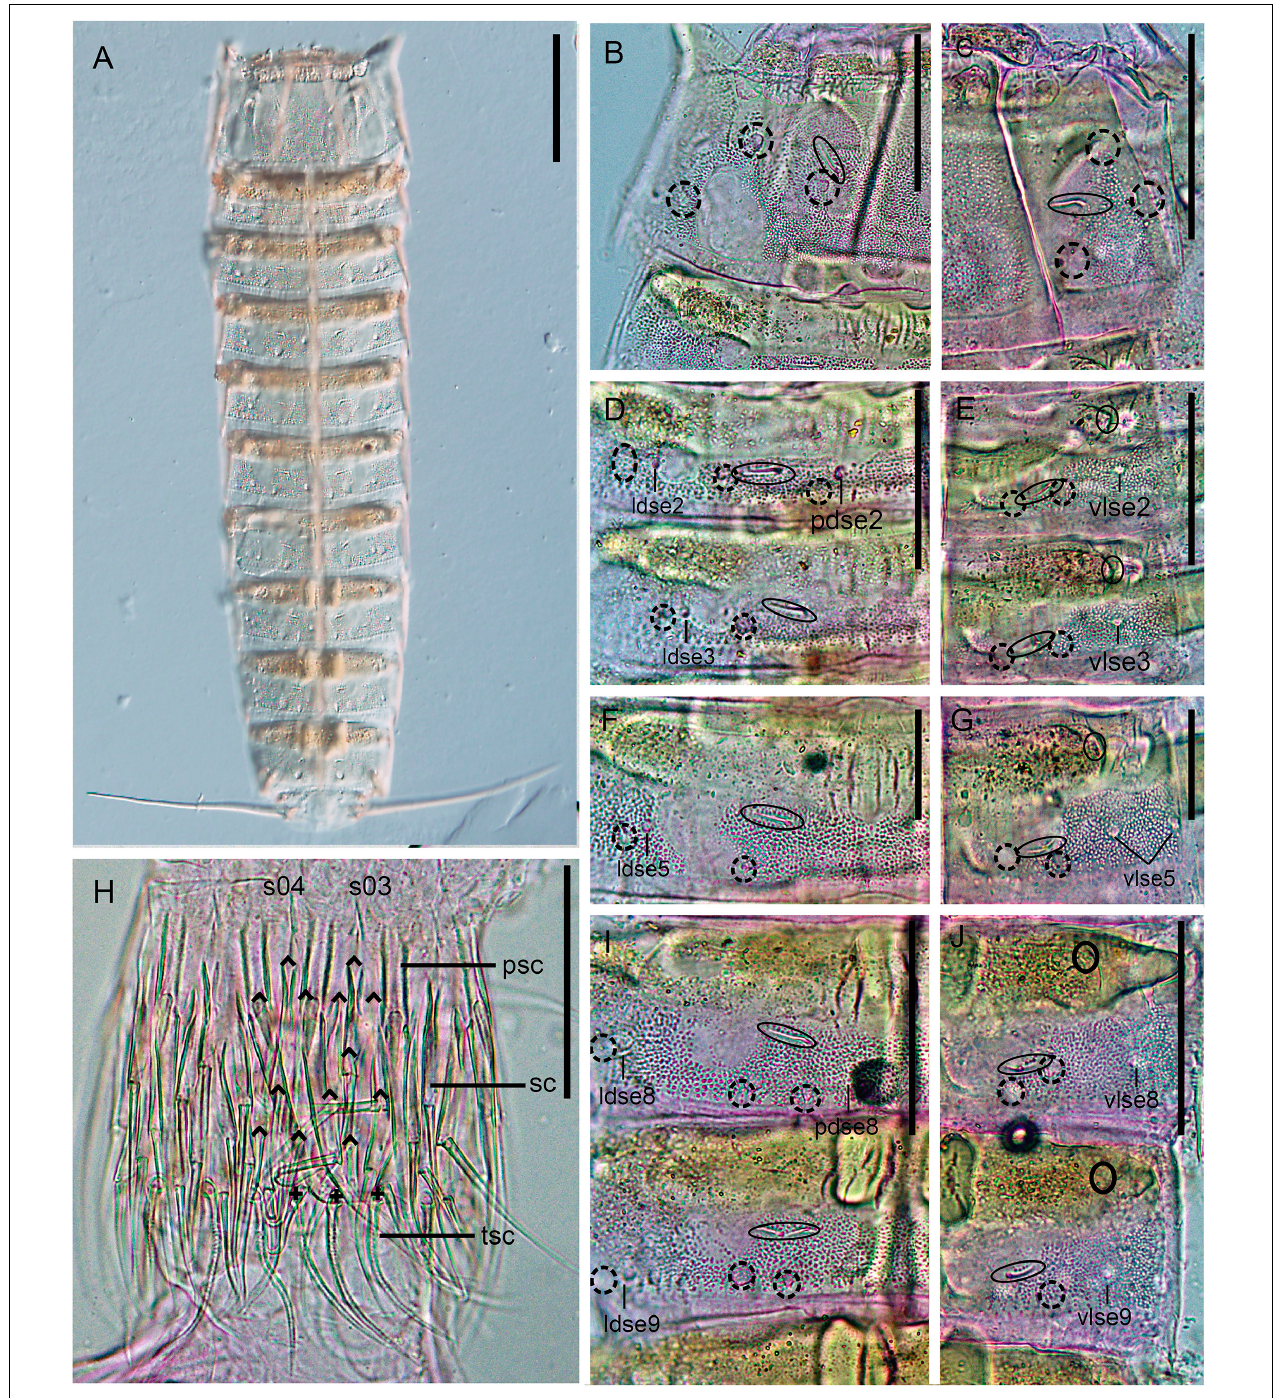
FIGURE 3 | Light micrographs showing trunk overview and details in the head and main trunk cuticular characters of female holotype NHMD 669762 (B–J) and male paratype NHMD 669763 (A) of Fujuriphyes dagon sp. nov. (A) Dorsal overview of trunk; (B) middorsal to paralateral view on right half of tergal plate of segment 1; (C) ventrolateral to ventromedial view on left half of sternal plates of segment 1; (D) middorsal to laterodorsal view on right half of tergal plate of segments 2–3; (E) left sternal plates of segments 2–3; (F) middorsal to laterodorsal view on right half of tergal plate of segment 5; (G) left sternal plate of segment 5; (H) introvert, with detail of primary spinoscalid, regular-sized scalid, and trichoscalid arrangement of sectors 03–04; (I) middorsal to laterodorsal view on right half of tergal plate of segments 8–9; (J) left sternal plates of segments 8–9. Scale bars (A): 250 µ m; (B–E, H–J) : 62 µ m; (F) and (G): 31 µ m. Abbreviations: ldse, laterodorsal seta; pdse, paradorsal seta; psc, primary spinoscalid; s, sector of introvert; sc, regular-sized scalid; tsc, trichoscalid; vlse, ventrolateral seta; numbers after abbreviations indicate corresponding segment or sector of introvert; carets indicate the arrangement of scalids, and crosses that of trichoscalids; sensory spots are marked as dashed circles, and glandular cell outlets as continuous